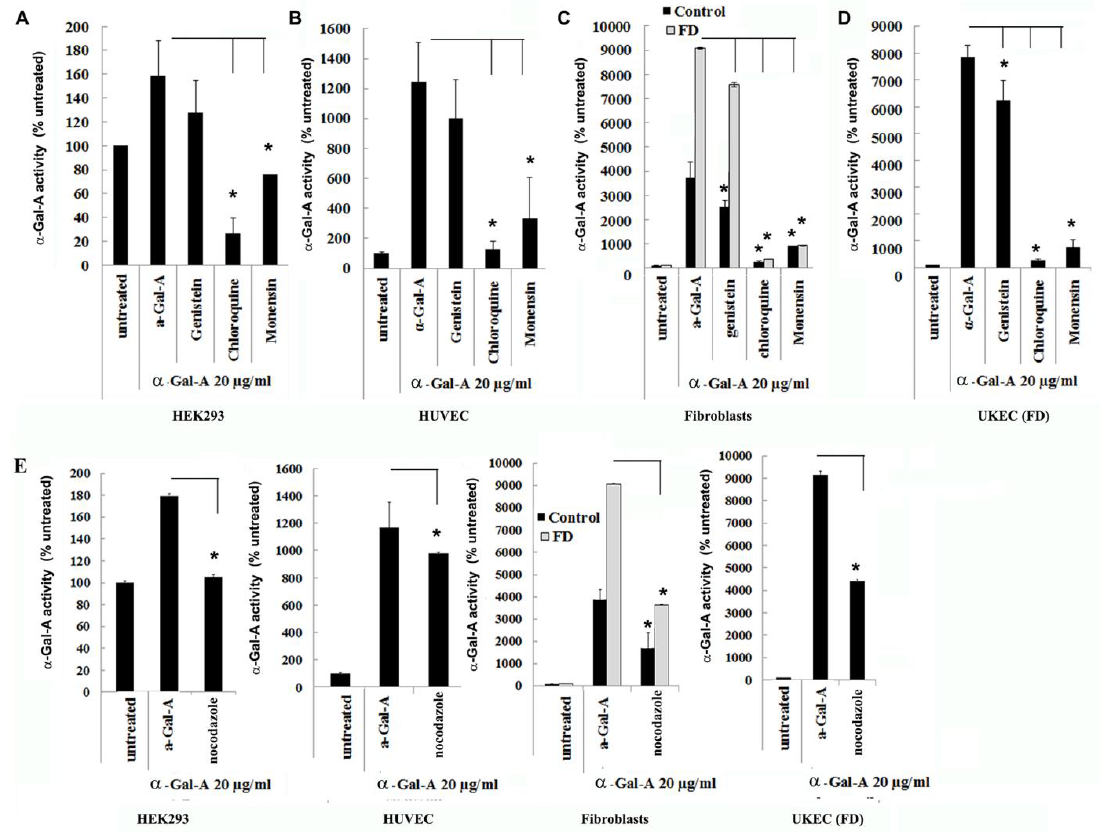
Figure 4. The rapid uptake of rh-α-Gal-A is achieved by clathrin and caveolae-mediated endocytosis. HEK293 ( A ), HUVEC ( B ), fibroblasts ( C ), and UKEC ( D ) cells were co-treated with the indicated concentration of rh-α-Gal A and inhibitors genistein, chloroquine, and monensin for 1 h. The enzyme assay was performed to determine the relative α-Gal A enzyme level. ( E ) HEK293, HUVEC, fibroblast, and UKEC cells were treated with the microtubule inhibitor, nocodazole. The enzyme assay was performed to determine the relative α-Gal A enzyme level. Values are average ±STDEV of minimum three experiments. * p < 0.01 vs. untreated control.